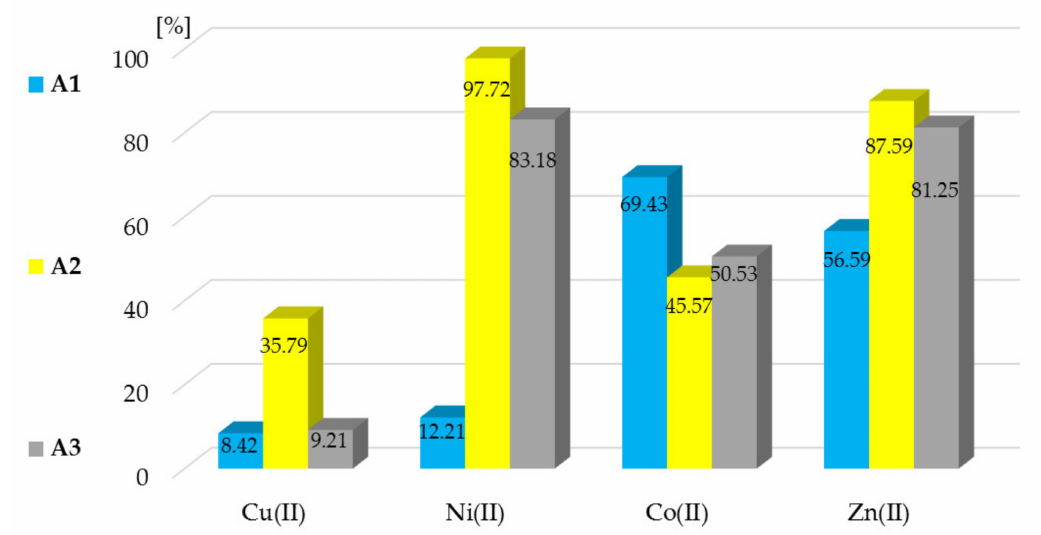
Figure 5. Recovery of metal ions in membrane extraction processes with 2,6-bis((benzoyl-R)amino)pyridine (R = H, 4-Me, and 4-NMe 2 ) derivatives as a carriers. The given values of the RF carry ± 0.01%.